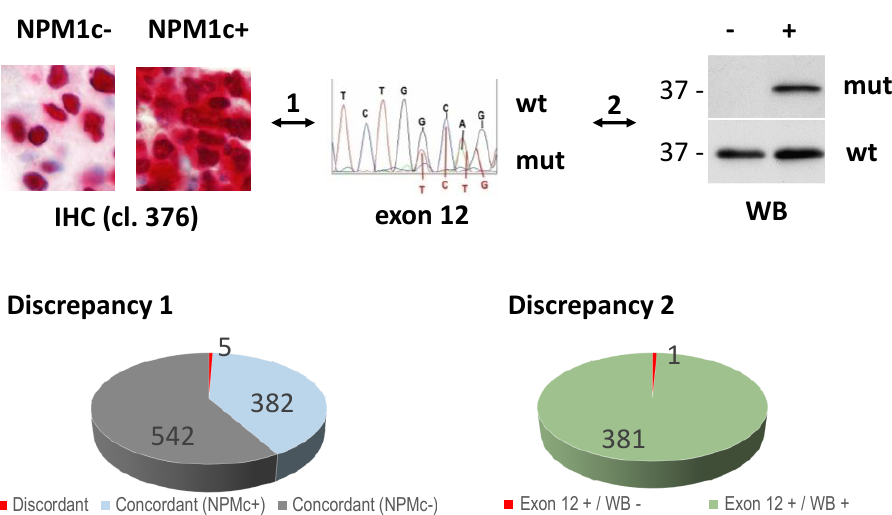
Figure 1. Study design and diagnostic discrepancies. Overall, 929 unselected AML patients were studied by multiple diagnostic approaches (i.e., immunohistochemistry, IHC; standard molecular analysis for NPM1 exon 12, and Western blotting with specific anti-NPM1 mutant antibody, WB). 1 indicates comparison between IHC and NPM1 exon 12-molecular analysis. 2 indicates comparison between NPM1 exon 12-molecular analysis and WB. wt: wild type (exon 12 wild type); mut: mutated (exon 12 mutation A and other non-A mutations). Discrepancy 1 indicates NPM1c+ at IHC and NPM1 exon 12 wild-type (reported in [17]). Discrepancy 2 indicates NPM1c+ with mutation in exon 12 (Exon 12 +), but Western blotting (WB) negative with anti-NPM1 mutant antibody, recognizing either NPM1 mutant A and other previously described non-A mutants [20] .